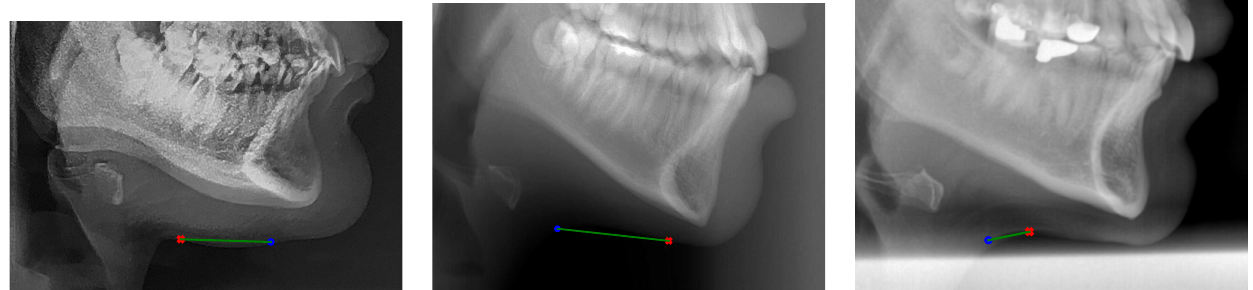
Figure 5. The worst-detected landmark Th’ by using the SCN-EXT method: three examples from the AUDAX database. Estimated landmarks are denoted by a red x, while ground-truth locations are superimposed as blue